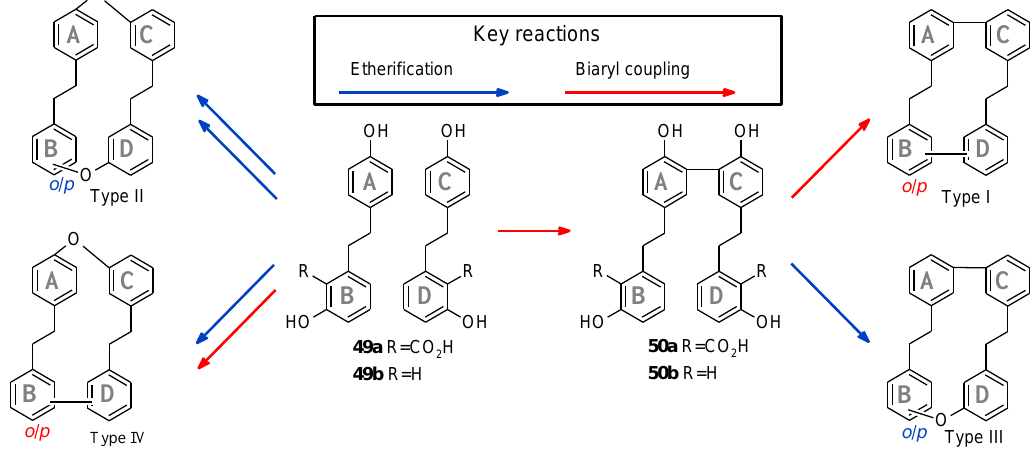
Figure 7. Structural relationships and interconversion of natural occuring bis(bibenzyl)s.